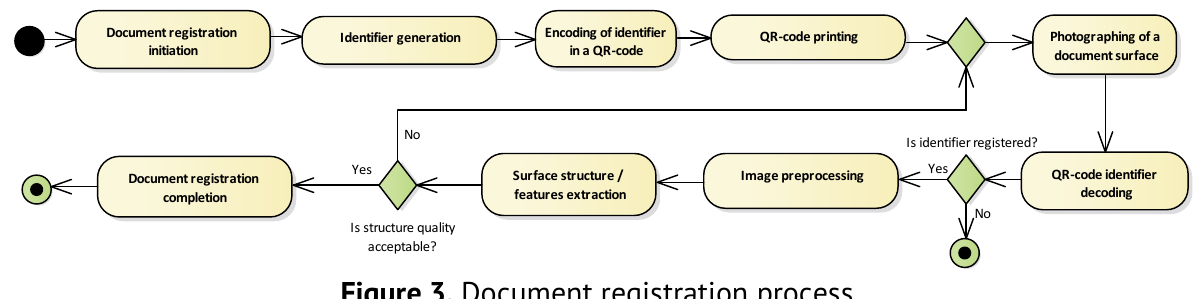
Figure 3. Document registration